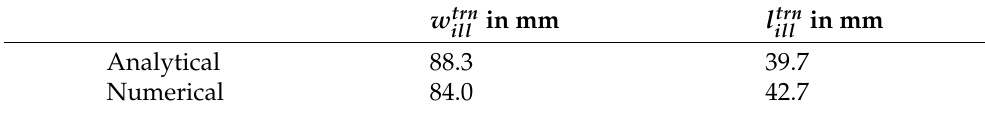
Figure 2. Numerical dimensions of the illuminating area of the UWB antenna used. ( a ) The electric field received at d prb from the probe in the time domain. ( b ) The width of the propagated wave at ill − 3 dB from the maximum amplitude at a distance of d prb . ill Table 1. Analytical and numerical dimensions of the illumination